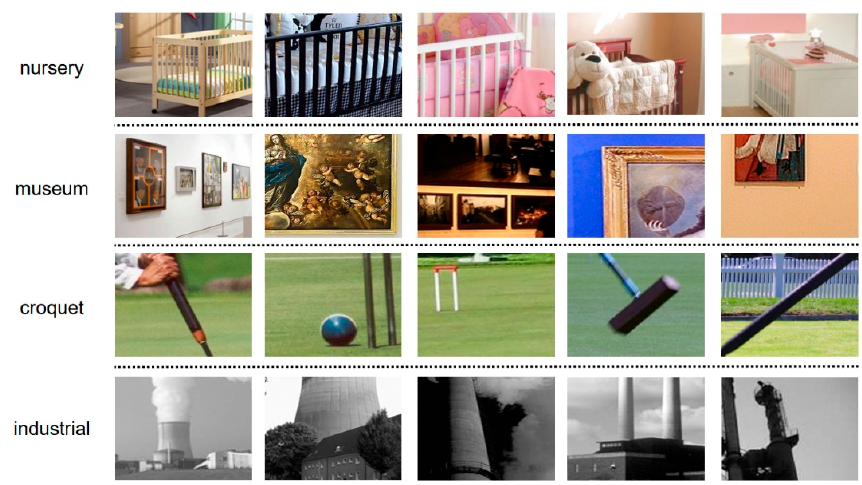
Figure 12. Examples of discriminative regions discovered by our WS-AM method.